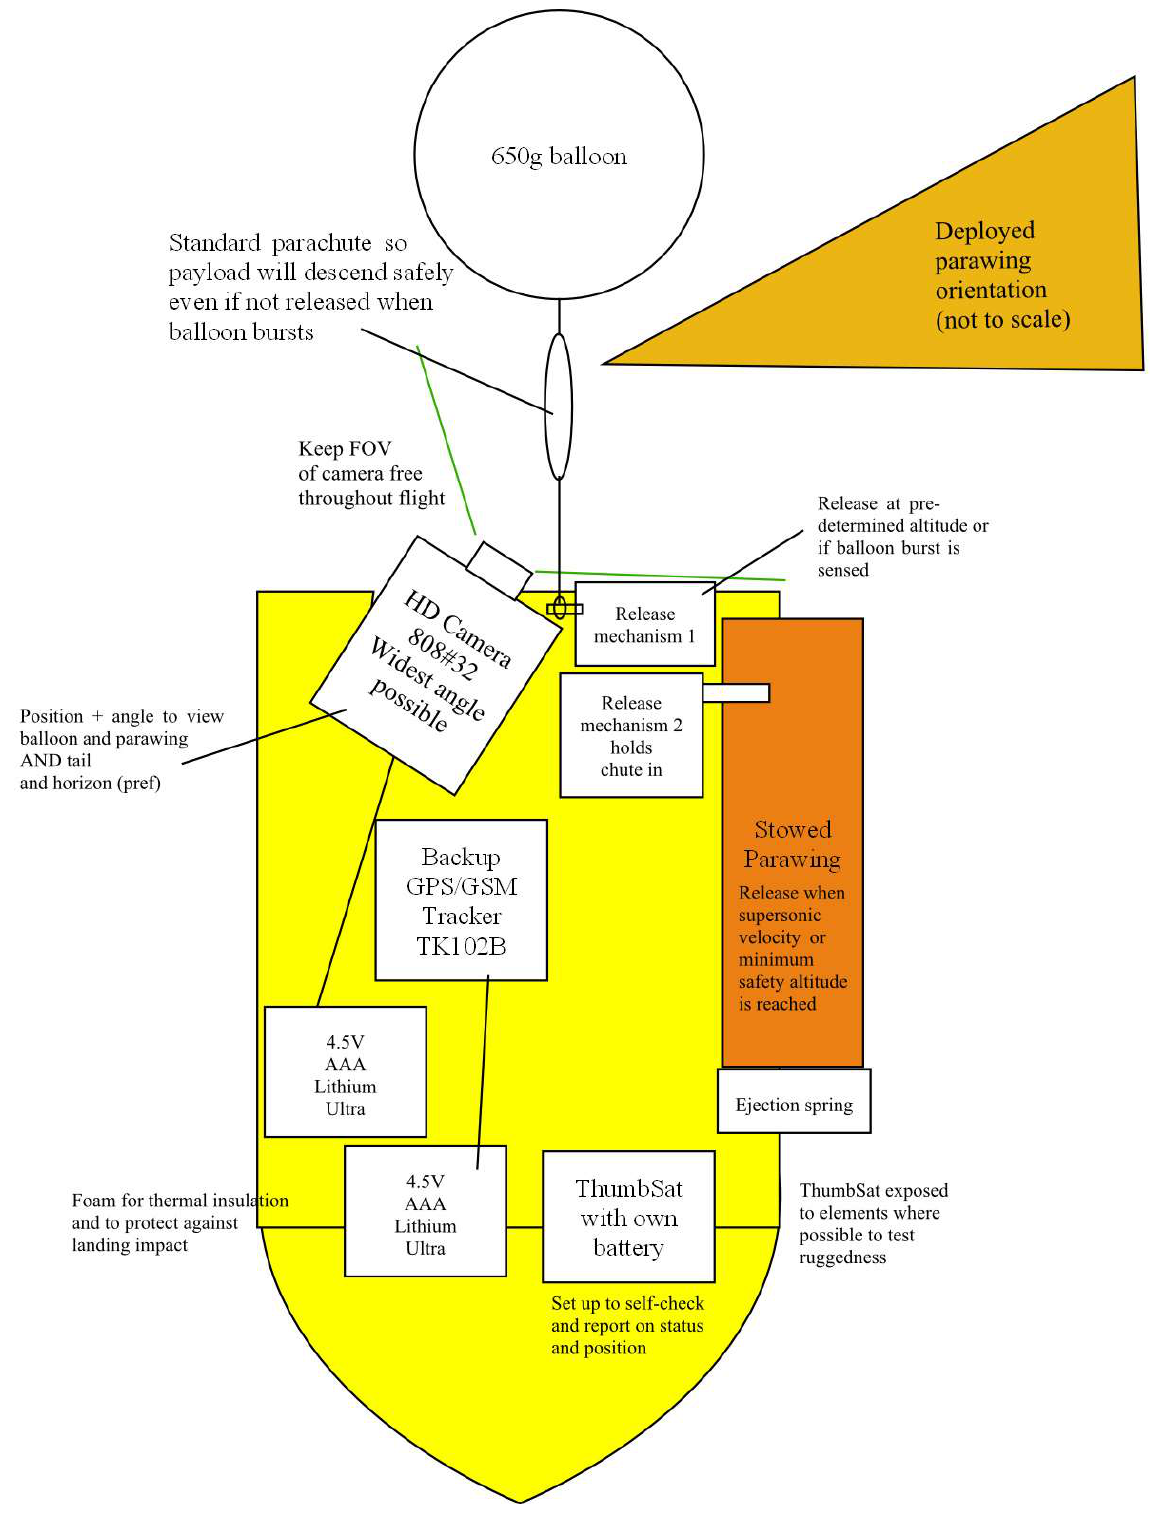
Figure 1. Concept schematic (not to scale).